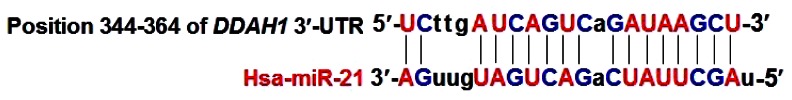
The prediction of miR-21 binding site in DDAH1 3′-UTR with the online software Target Scan.